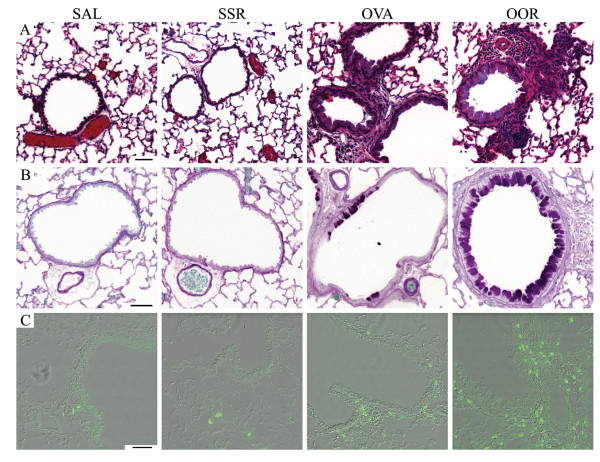
Enhanced pulmonary histopathology is observed in mice exposed to Ova and RSV. Lung sections from formalin-fixed, paraffin-embedded tissue were stained for A) cellularity, B) mucus (purple), and C) eosinophils (green) as described in the materials and methods section. The photographs are representative of the staining that occurs in the bronchioles of SAL, OVA, SSR, and OOR exposed mice. Although not shown, the RSS resembled the SSR group and the ROO group was not significantly different from the OVA mice. Scale bar = 50 μm.